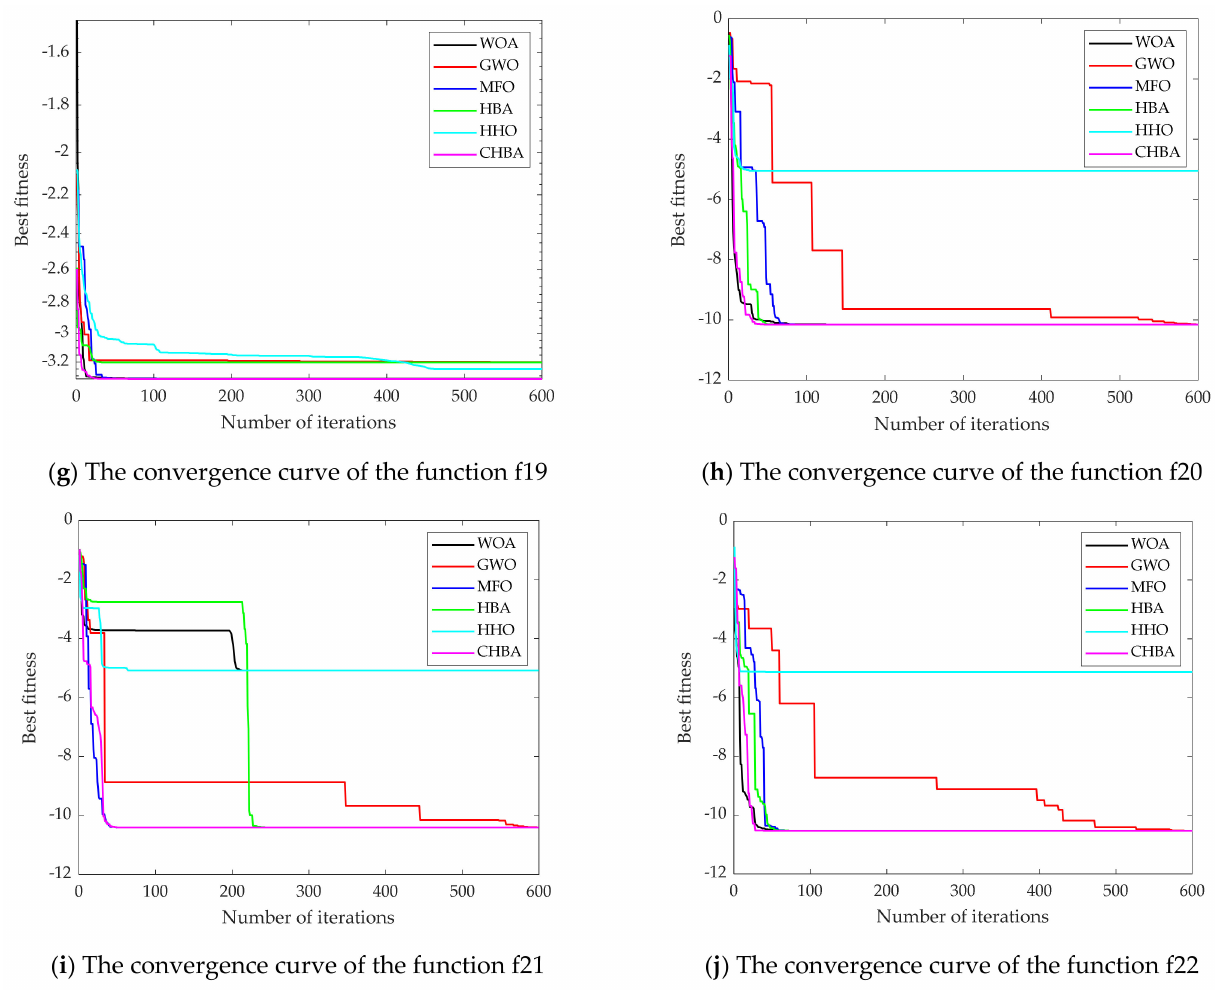
Figure 6. Convergence curve of low-dimensional test